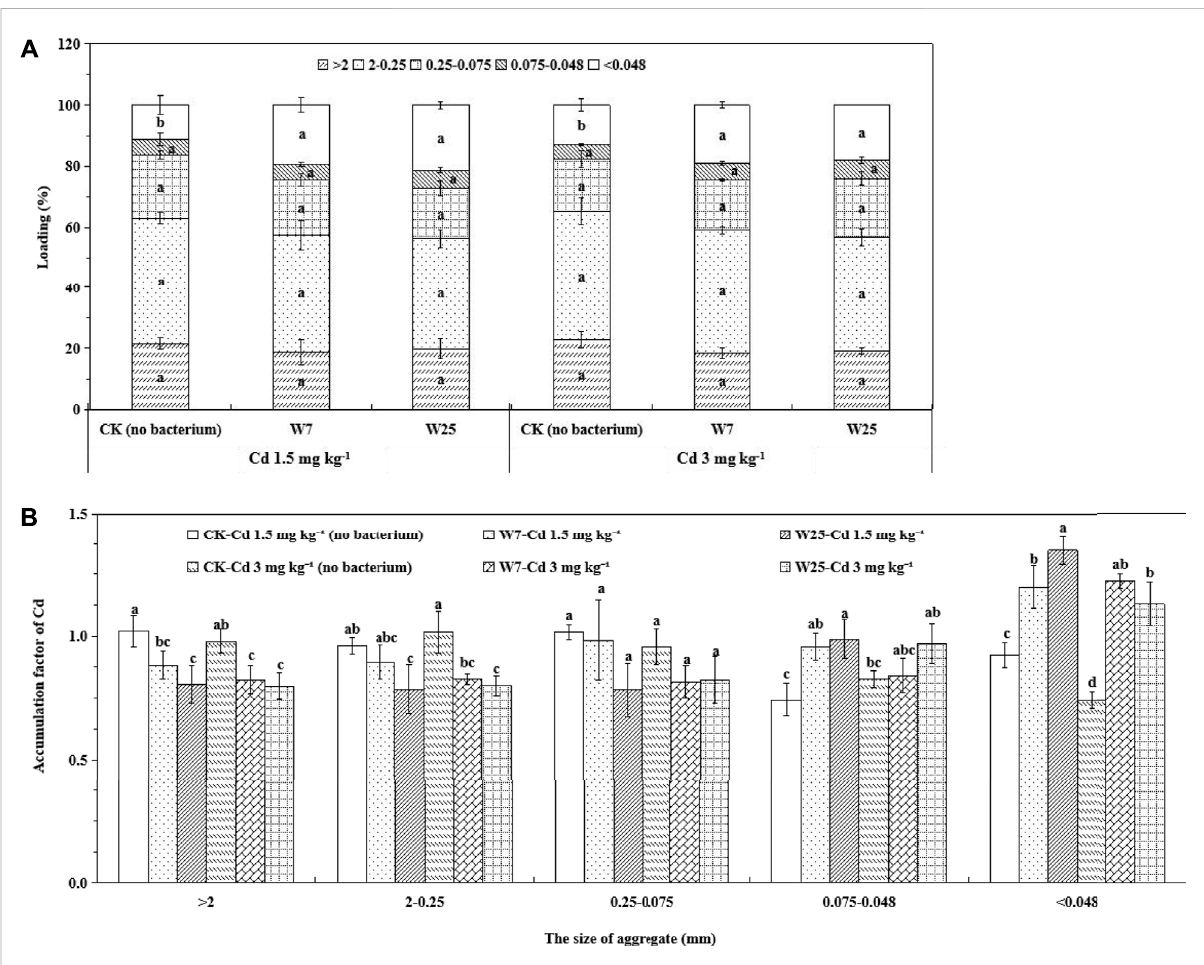
FIGURE 5 Effects ofstrains W7 and W25on theGSFloading (A) and AFx (B) values ofsoil aggregates in low andhigh Cd-contaminated rhizospheresoils of wheat. Error bars are ± standard error ( n = 3). Bars with the same letter within each treatment are not signi fi cantly different ( p > 0.05) according to Tukey ’ s